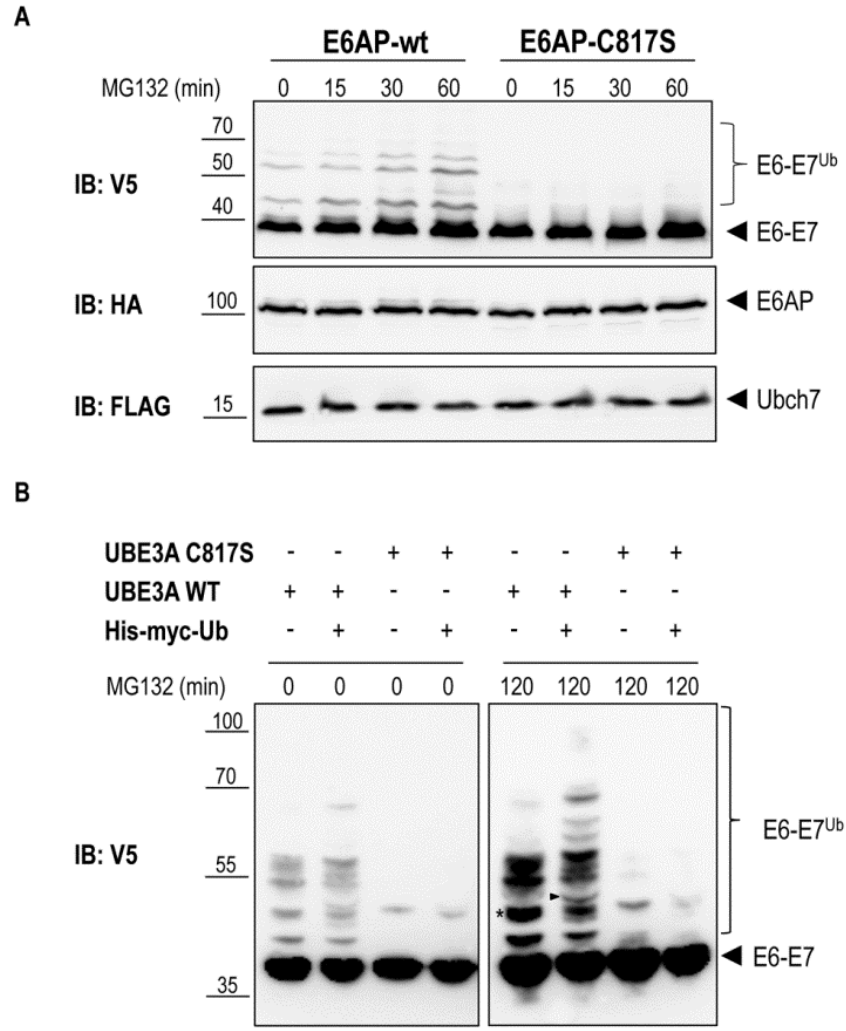
FIGURE 3: E6AP-dependent ubiquiti- nation of E6-E7. (A) Yeast strain yRA2 was transformed with E6AP (wild type or catalytically inactive mutant) cloned in pRA306 (HA tag, LEU2 marker, TEF promoter), UBCH7 cloned in pRA300 (Flag tag, URA3 marker, TEF promoter) and E6-E7 cloned in pRA20 (V5 tag, TRP1 marker, 93%-GAL1